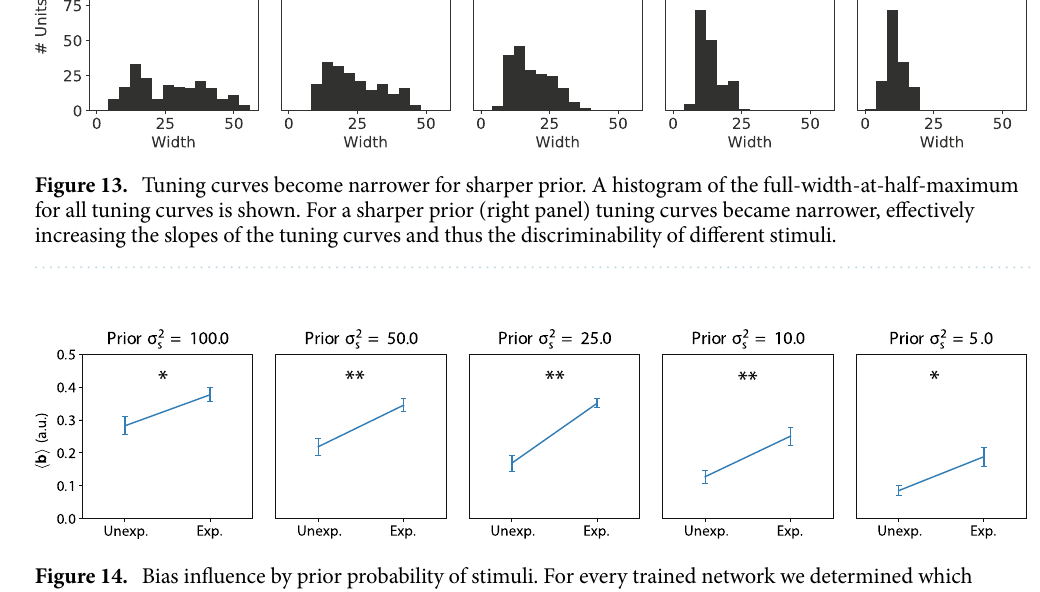
Figure 14. Bias influence by prior probability of stimuli. For every trained network we determined which neurons were sensitive to ‘expected’ stimuli and which were sensitive to ‘unexpected’ stimuli. The bias was much stronger for neurons sensitive to expected stimuli for all prior probability distributions. (* p < 0.02 , ** p < 0.005